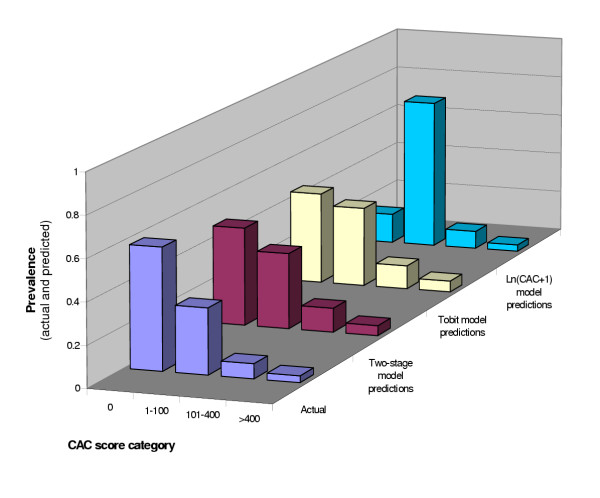
Comparison between actual and predicted CAC score distributions among a subset of the study population using three different modeling strategies. Actual prevalence measurements were from the 58- to 62-year-old non-smoking women in our study sample with hypertension, high cholesterol level, and no diabetes (n = 127). The "two-stage model predictions" use the coefficients presented in Tables 2 and 3 (the full model). The Ln(CAC+1) model predictions are from a linear regression model including all conventional CHD risk factors using Ln(CAC score +1) as a continuous outcome in a one-step modeling process (coefficients not presented). The Tobit model uses the cube-root of the CAC score as a continuous outcome for linear regression analysis, but assumes that scores at or below zero have been censored (coefficients not presented). P-values refer to a X2 test with 3 degrees of freedom comparing the expected frequencies based on each model with the observed frequencies. Lower p-values indicate a poorer model fit. CAC – Coronary artery calcium; CHD – Coronary heart disease; Ln – Natural logarithm.